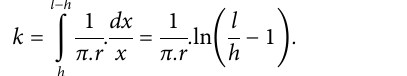
Frontiers in Energy Research |